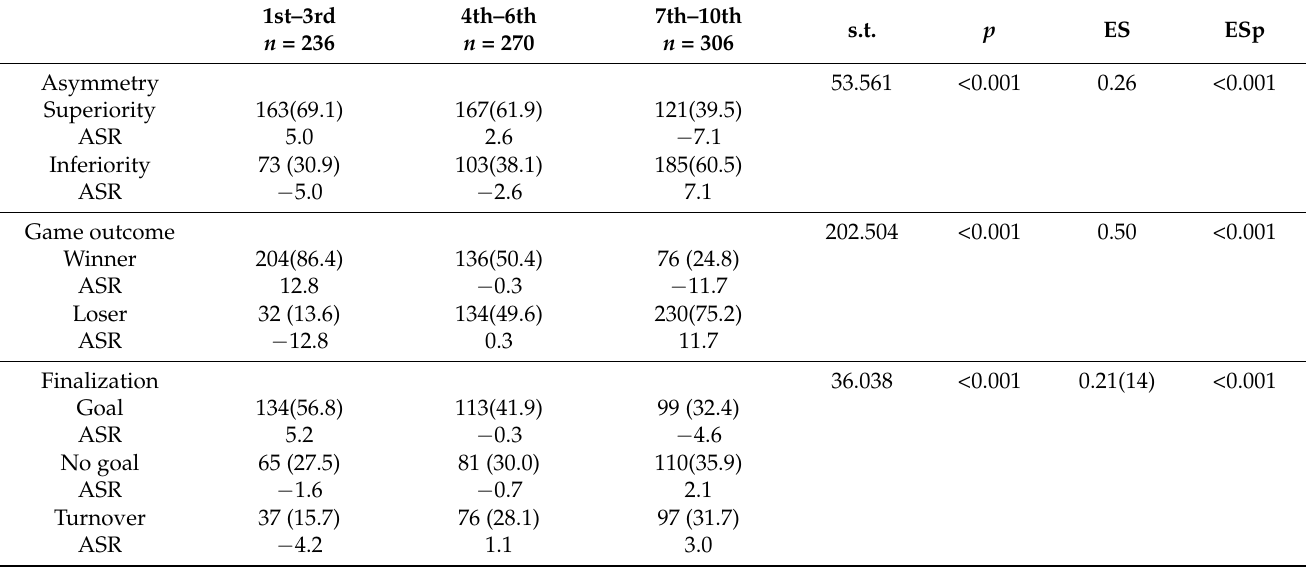
Table 2. Frequency distribution of offensive situations under inequality during the